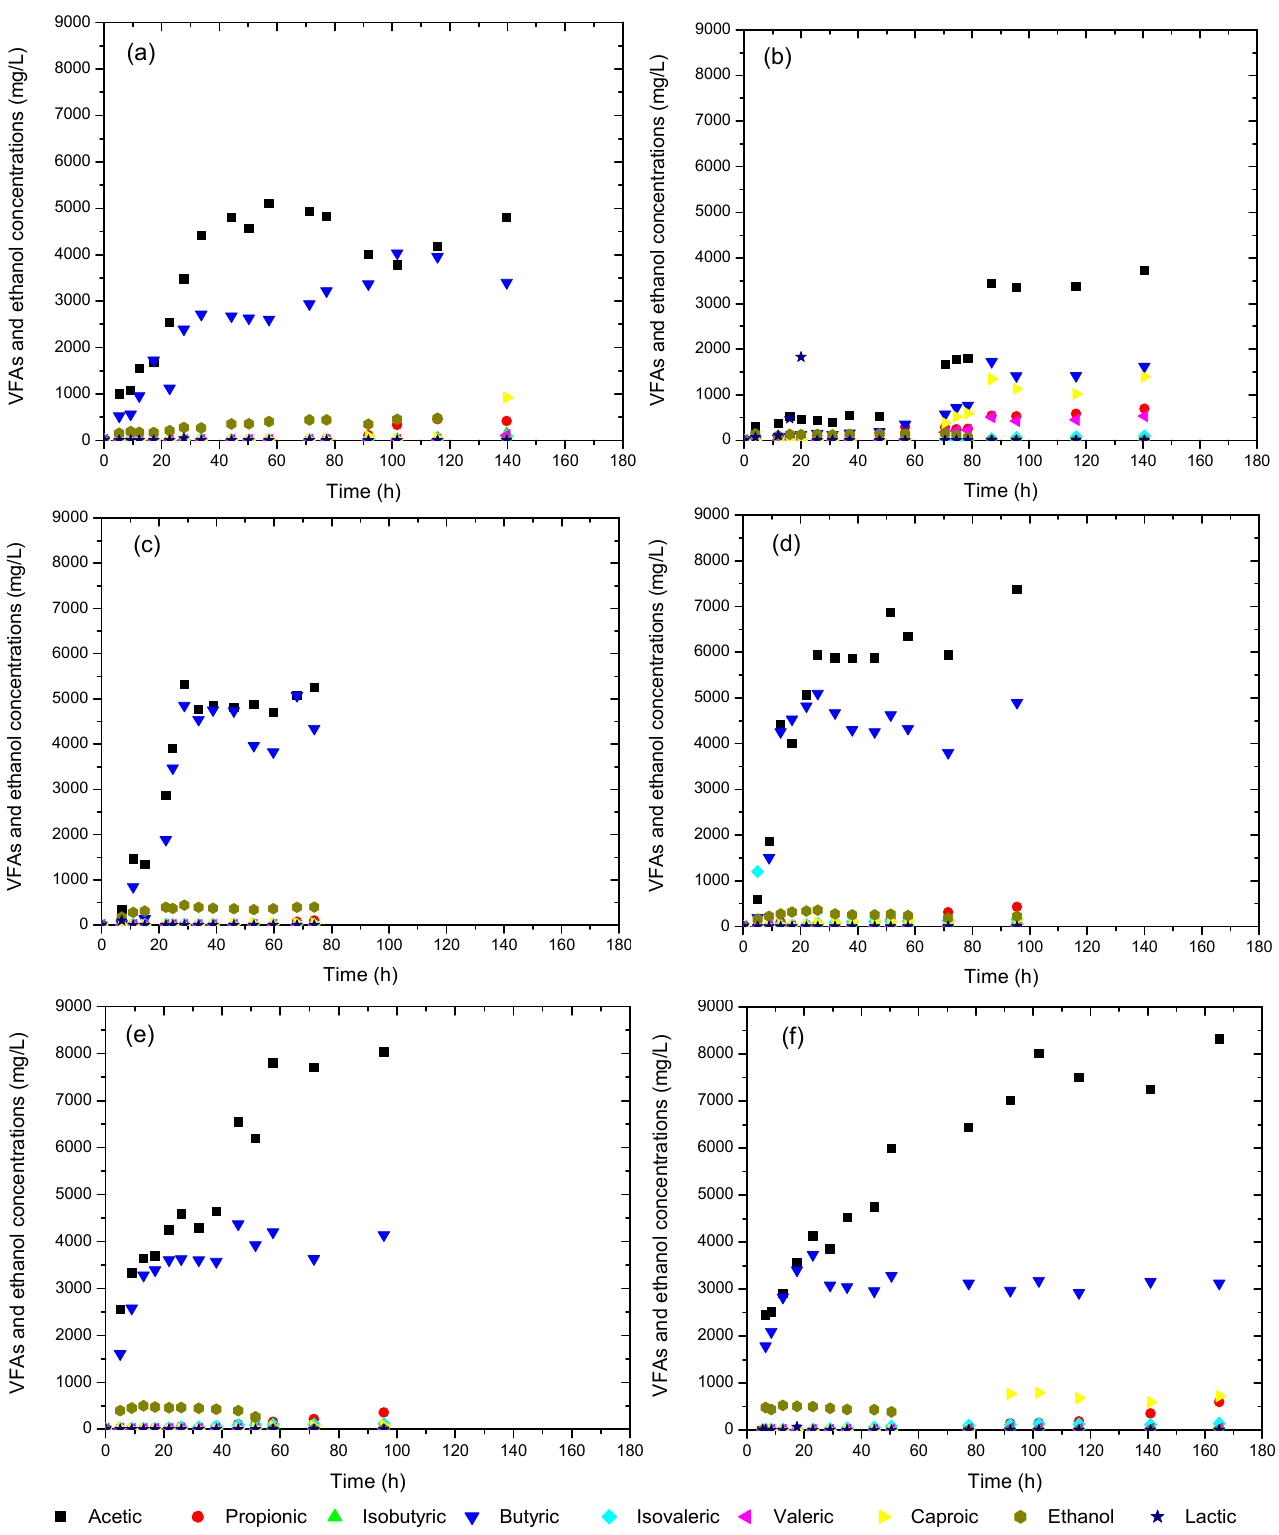
Figure 3. Concentrations of VFAs and ethanol during the batch dark fermentation of used adult diapers hydrolysate and expired food products, at ( a ) pH 4.5, ( b ) pH 5, ( c ) pH 5.5, ( d ) pH 6, ( e ) pH 6.5, and ( f ) pH 7.